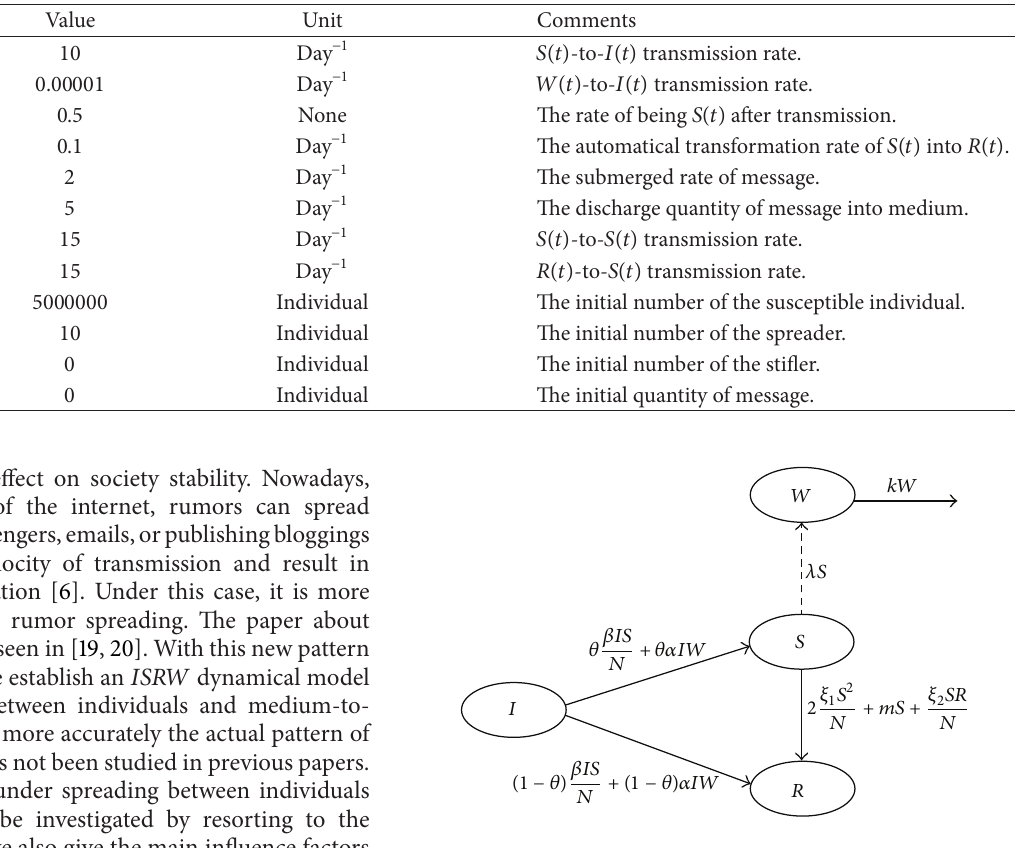
Table 1: Description of parameters in the model (5).